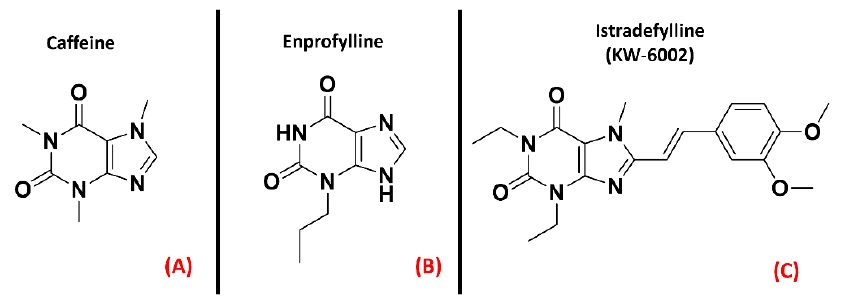
Figure 2. The chemical structures of the non-selective adenosine receptors antagonistscaffeine ( A ) and Enprofylline ( B ), and the selective A 2A AR antagonist Istradefylline ( C ).